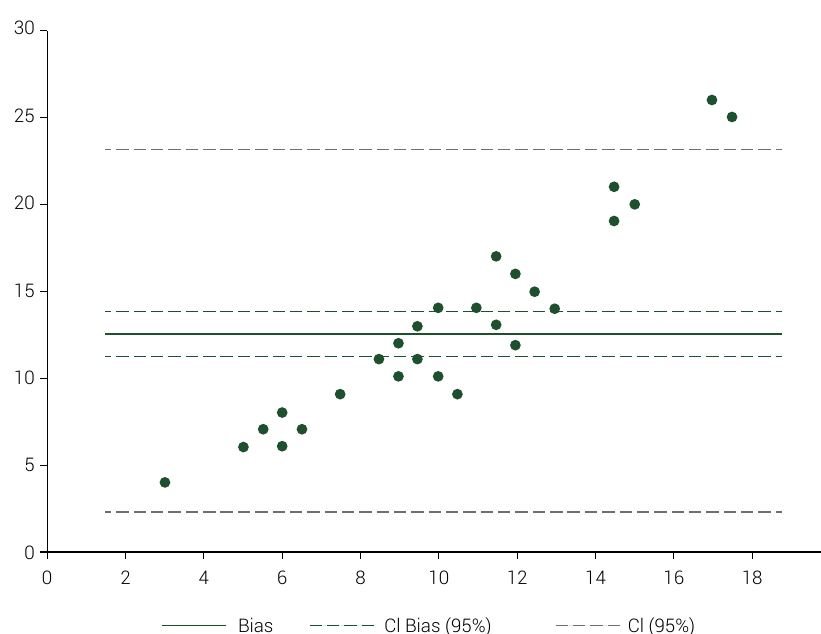
Figure 2. Bland-Altman plot for FISS and MFISS scoring